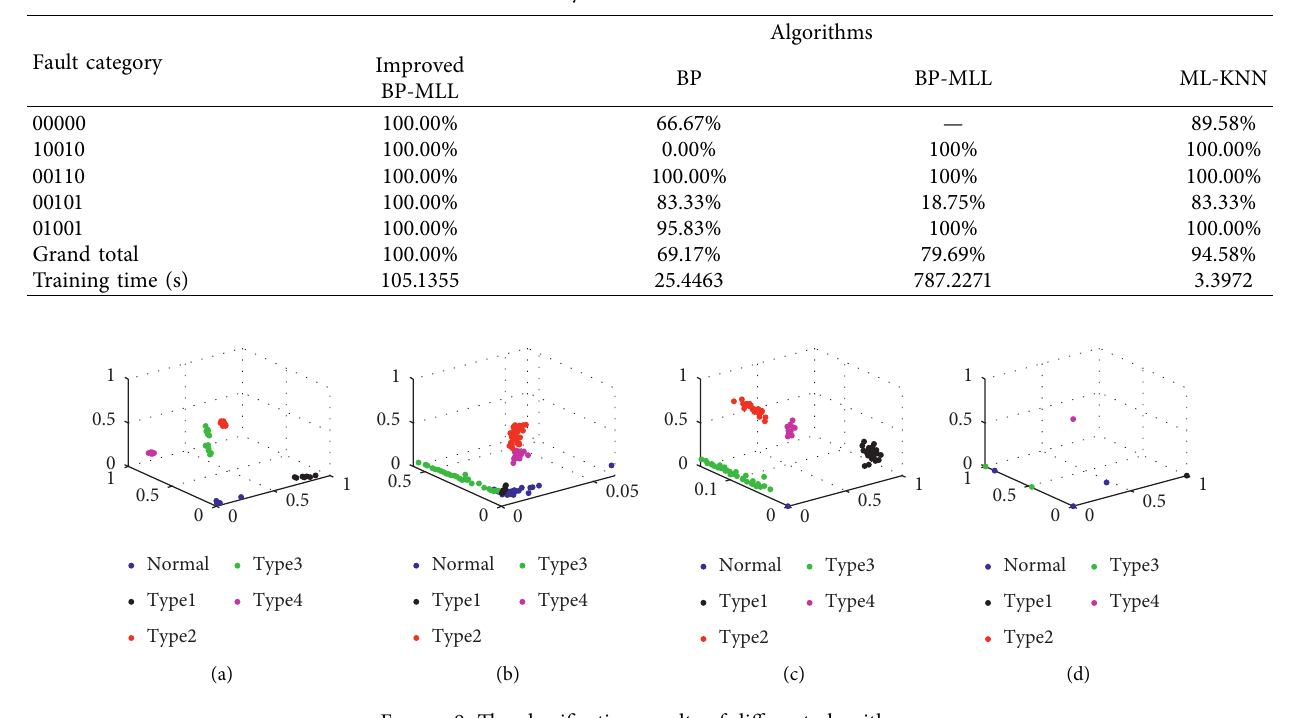
Table 5: Accuracy for different simultaneous